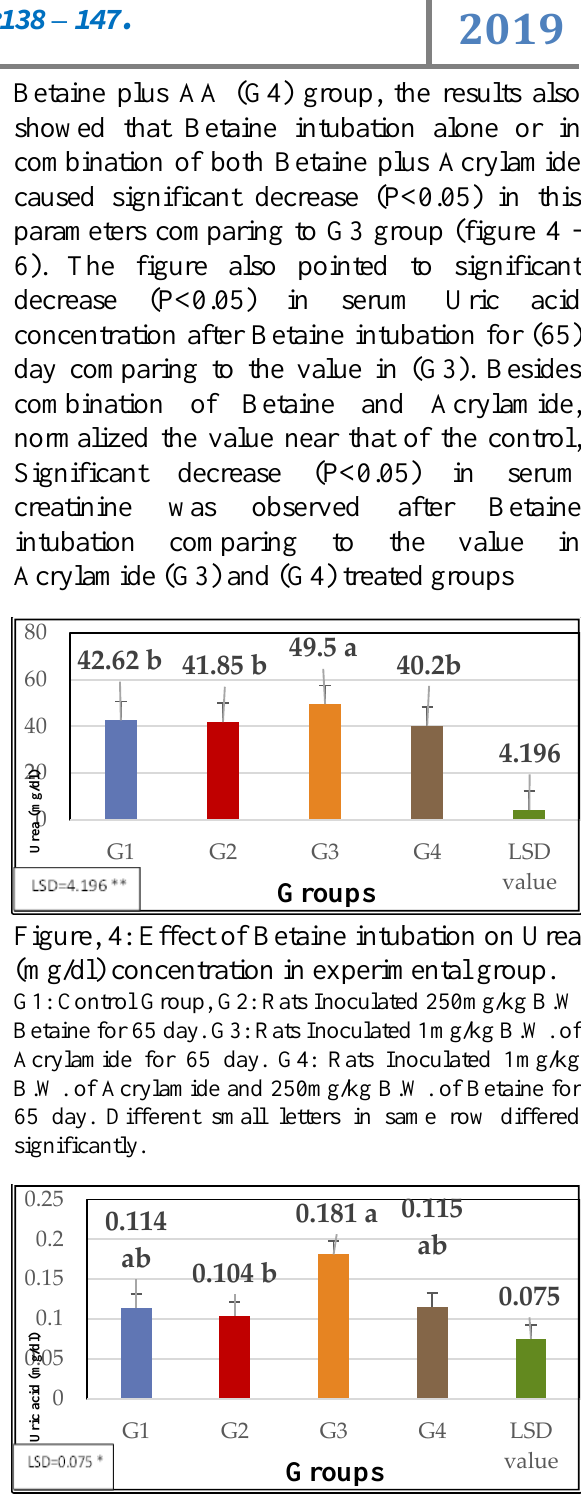
Figure, 5: Effect of Betaine intubation on Uric acid concentration in experimental